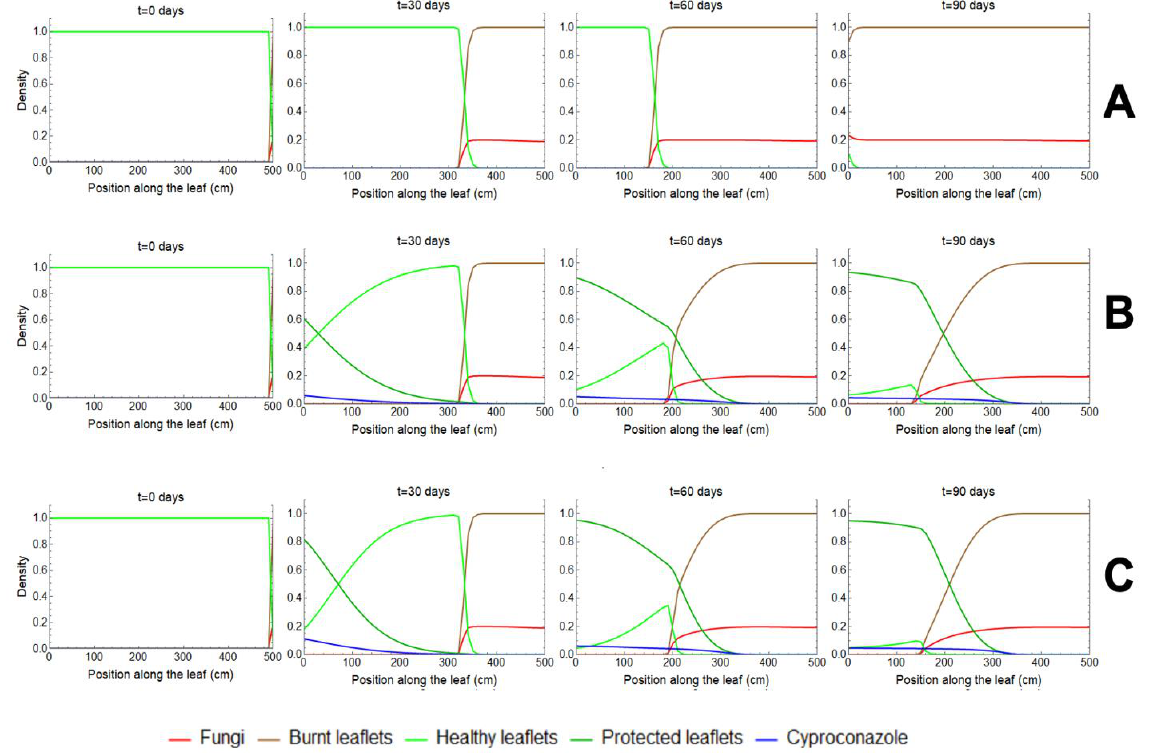
Figure 3. “Leaf model” simulations. Each panel shows snapshots of the leaf profile at a given time, with the leaflet/fungi/cyproconazole densities varying along the leaf. ( A ) The first row shows the leaf for the nontreated situation, i.e., the “leaf model” without cyproconazole entering the leaf. ( B , C ). The second and third rows showed leaf snapshots when 10 mL of cyproconazole was applied at day 0 with the nonpressurized ( B ) or pressurized ( C ) methods for a 5 m tall tree. In all panels, the cyproconazole densities are multiplied by 10 3